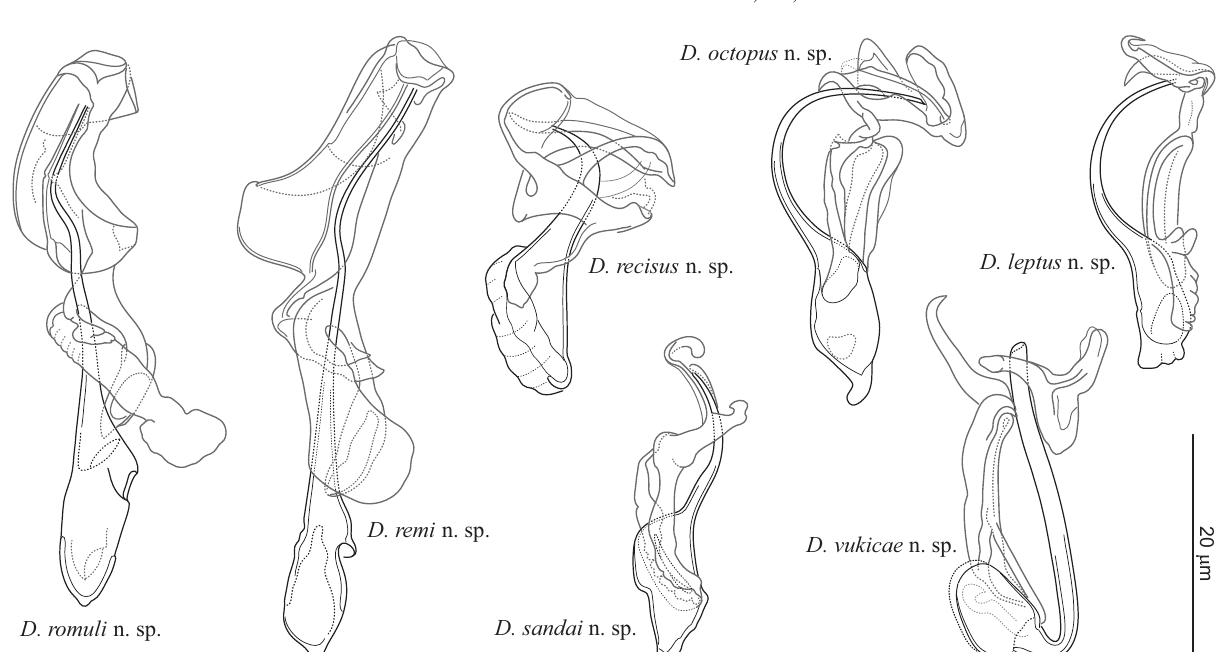
Figure 13. Dactylogyrus spp. (MCOs of hologenophores) parasitizing cyprinoids in the Balkan